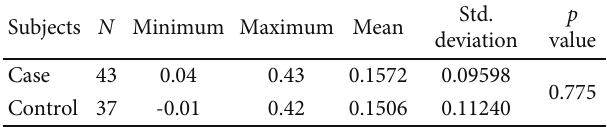
Table 5: Comparison of OSI between case and control groups. Subjects N Minimum Maximum Mean